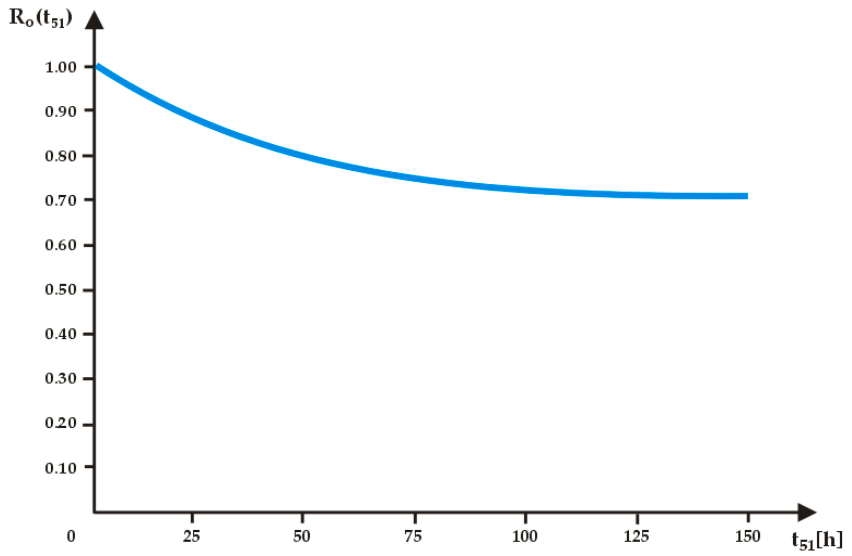
Figure 8. Dependence between the likelihood that the examined WFD system will continue to be fully fit after being restored—own study.